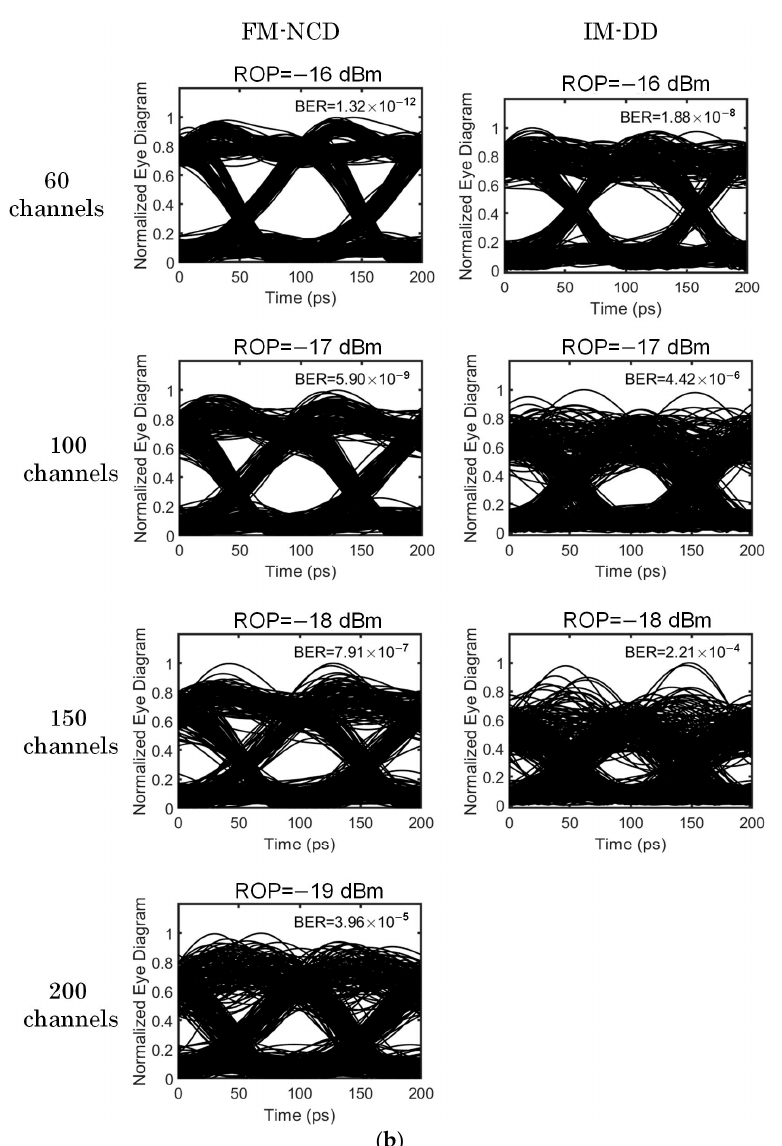
Figure 7. ( a ) BERs and ( b ) eye diagrams of the proposed FM-NCD system and the IM-DD system with di ff erent system capacities.